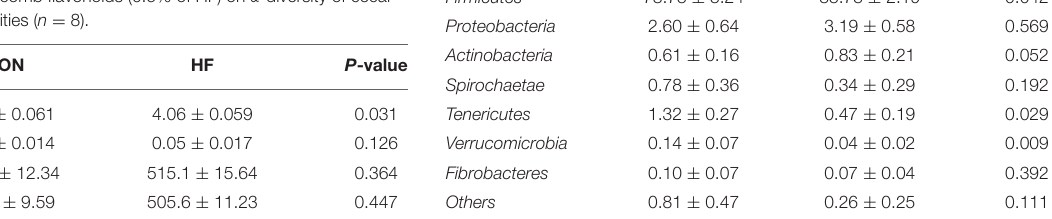
Frontiers in Veterinary Science |